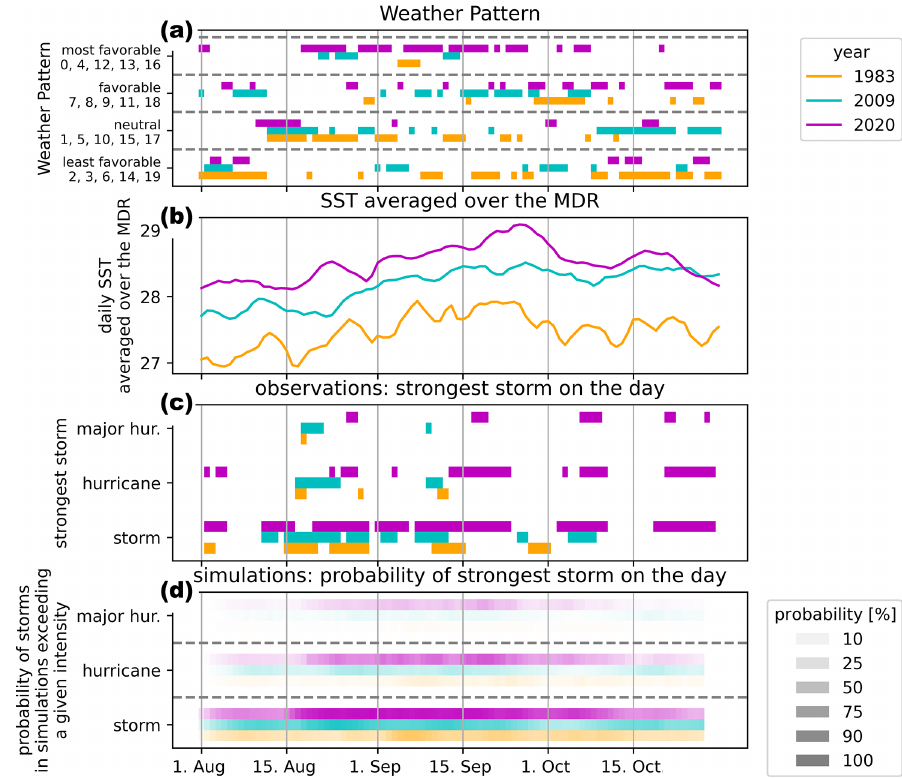
Figure 3. Functioning of the tropical cyclone emulator. (a) Sequence of daily weather patterns grouped into four categories from least favorable for TC formation and intensification to most favorable for the years 2020 (purple), 2009 (cyan) and 1983 (orange). (b) Daily SSTs averaged over the main development region for the same years. (c) Intensity of the strongest storm for each day grouped into the categories storm, hurricane and major hurricane. (d) Probability of exceeding the intensity thresholds of panel (c) in simulations from the